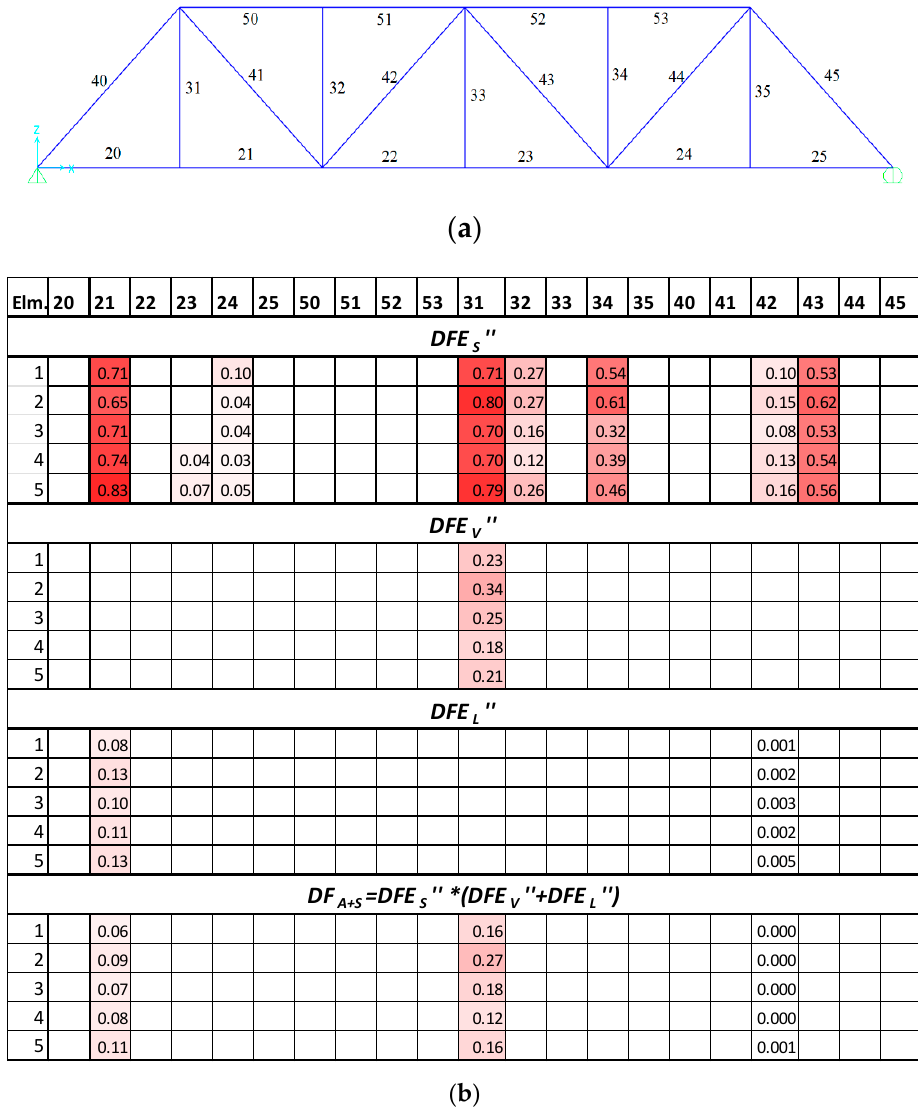
Figure 12. ( a ) The actual location of damage for damage case-4, ( b ) Identified damage using the proposed framework for damage case-4.